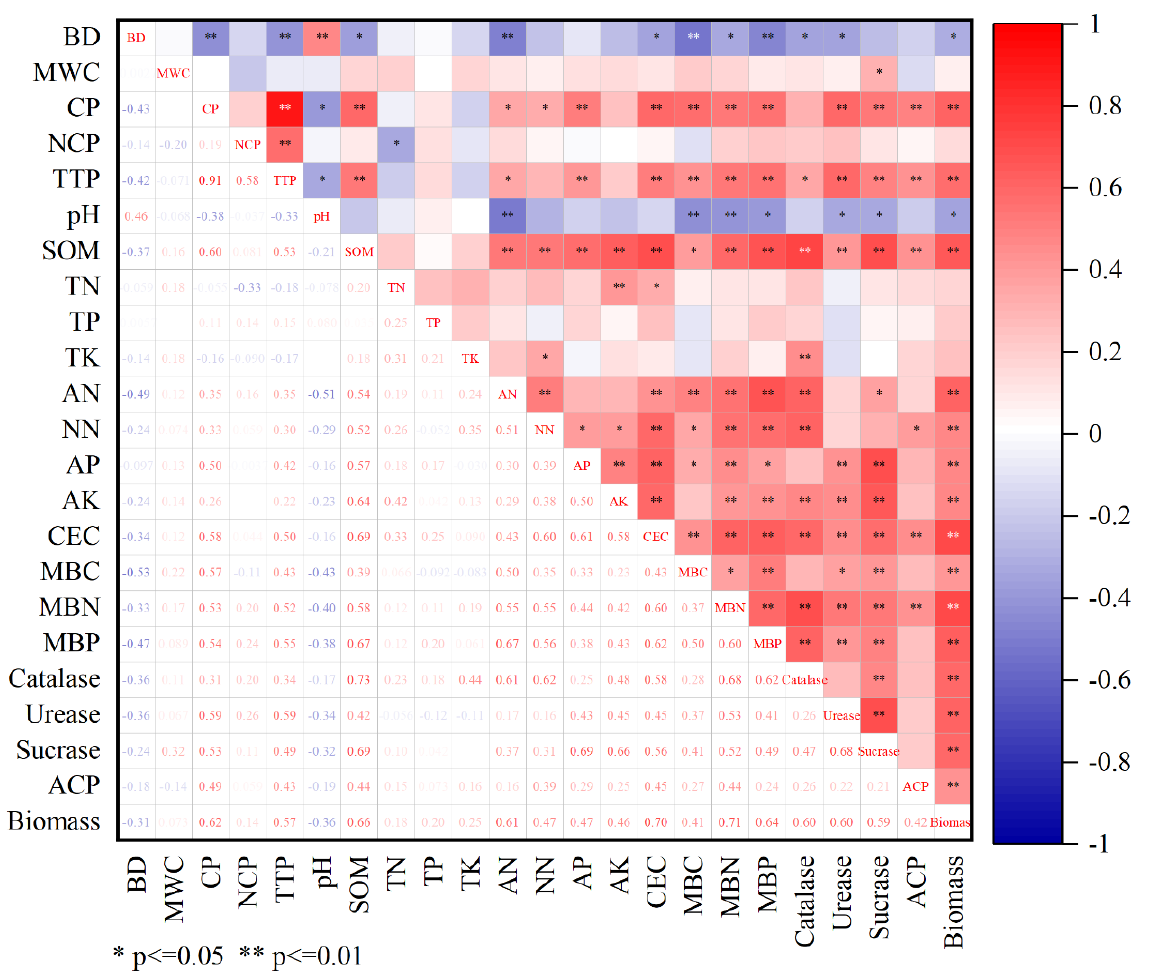
Figure 2. Pearson correlation analysis between quality indicators and biomass of Melaleuca alternifolia . Table 3. Soil physical properties of different residue treatment